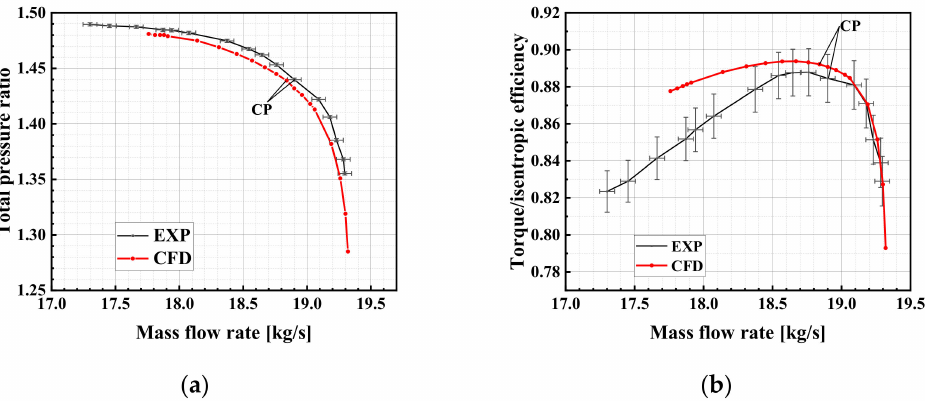
Figure 4. Performance lines of the reduced-scale 1.5-stage transonic compressor: ( a ) total pressure ratio; ( b ) torque/isentropic